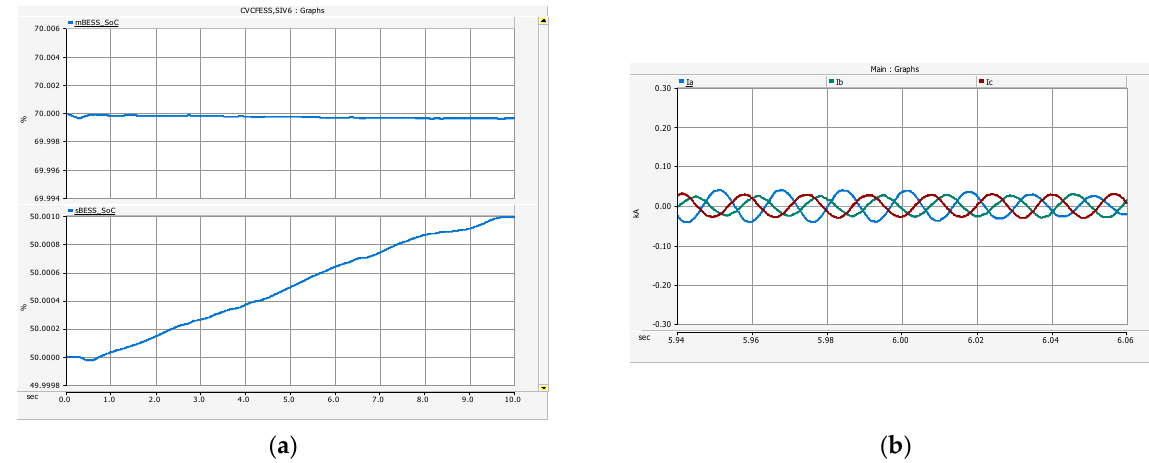
Figure 13. Simulation results of Scenario 2 ( a ) State of charge (SoC) (top: SoC of Main Battery energy storage system(mBESS); bottom: SoC of the sBESS) and ( b ) instantneous three-phase current of the mBESS.